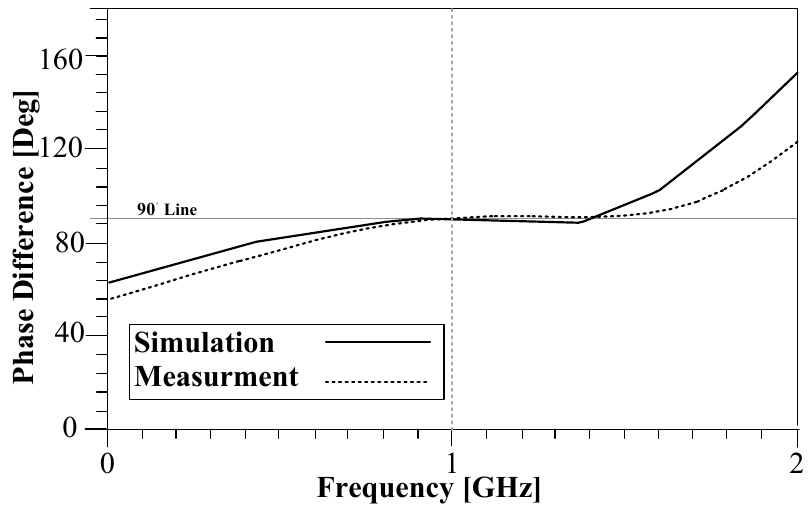
Figure 17. Measured and simulated phase difference in the proposed BLC. The photos of the fabricated BLC under test are depicted in Figure 18. The Hewlett Packard 8720 B network analyzer is used to measure the fabricated device, the applied network analyzer has a linear measurement process with 22 MHz step.